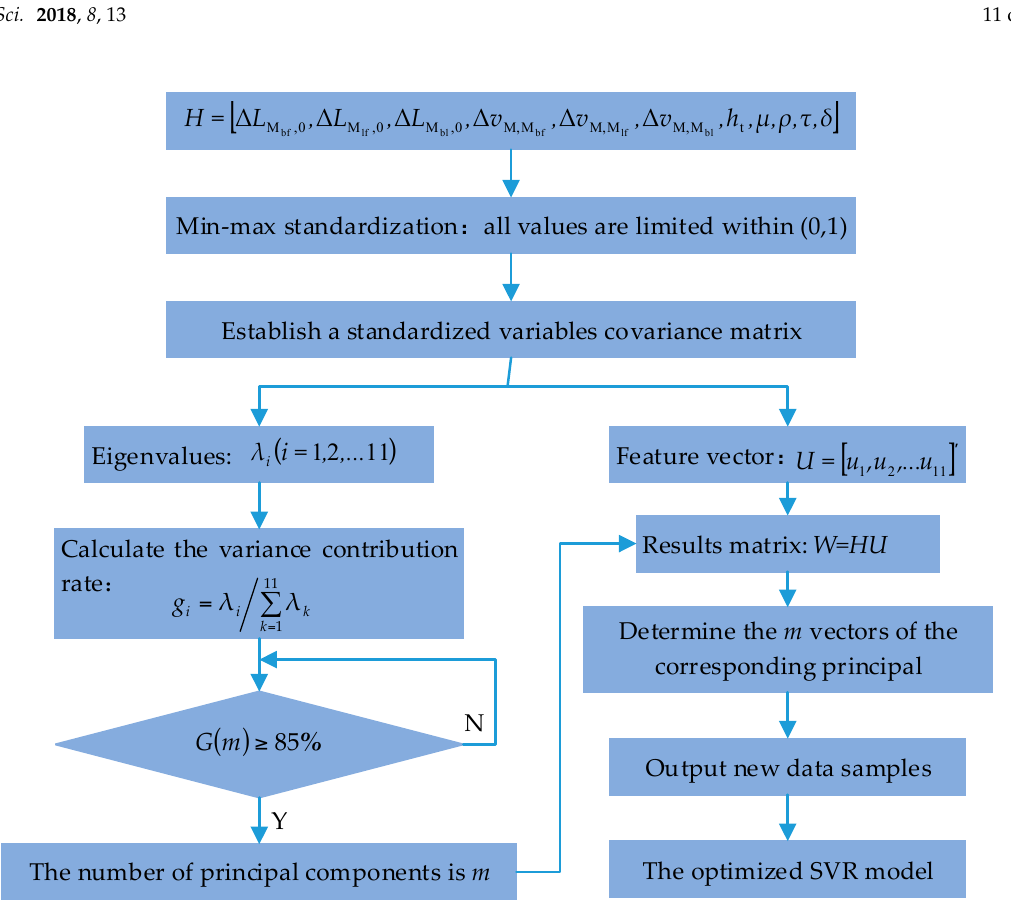
Figure 6. The analysis process of driving decision samples using Principal Component Analysis (PCA).